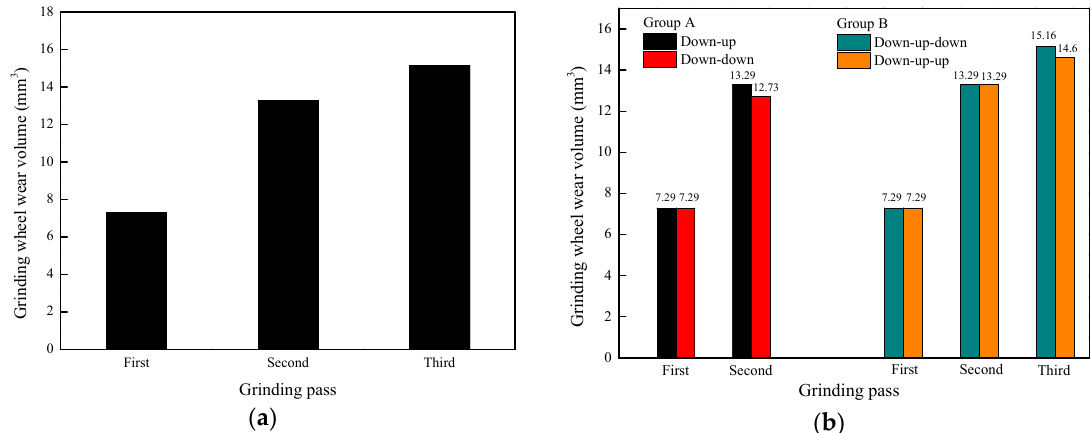
Figure 6. Change in the grinding wheel wear with ( a ) the number of grinding passes and ( b ) a change in the grinding direction.